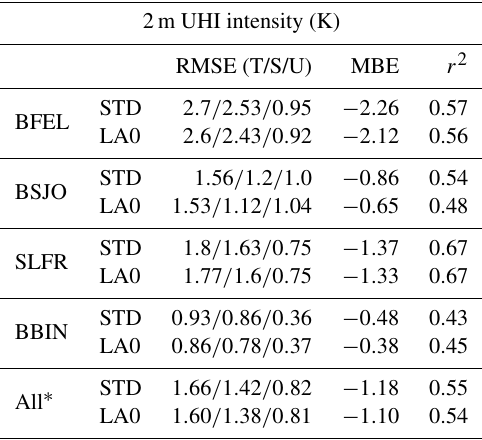
Table 6. RMSEs, MBEs and r 2 of the simulated 2m UHI intensity (K) at the sites of BFEL, BSJO, SLFR and BBIN during the study period. The BLER site is used as a rural reference. In addition to the total RMSEs (T), the systematic (S) and the unsystematic (U) RMSEs are